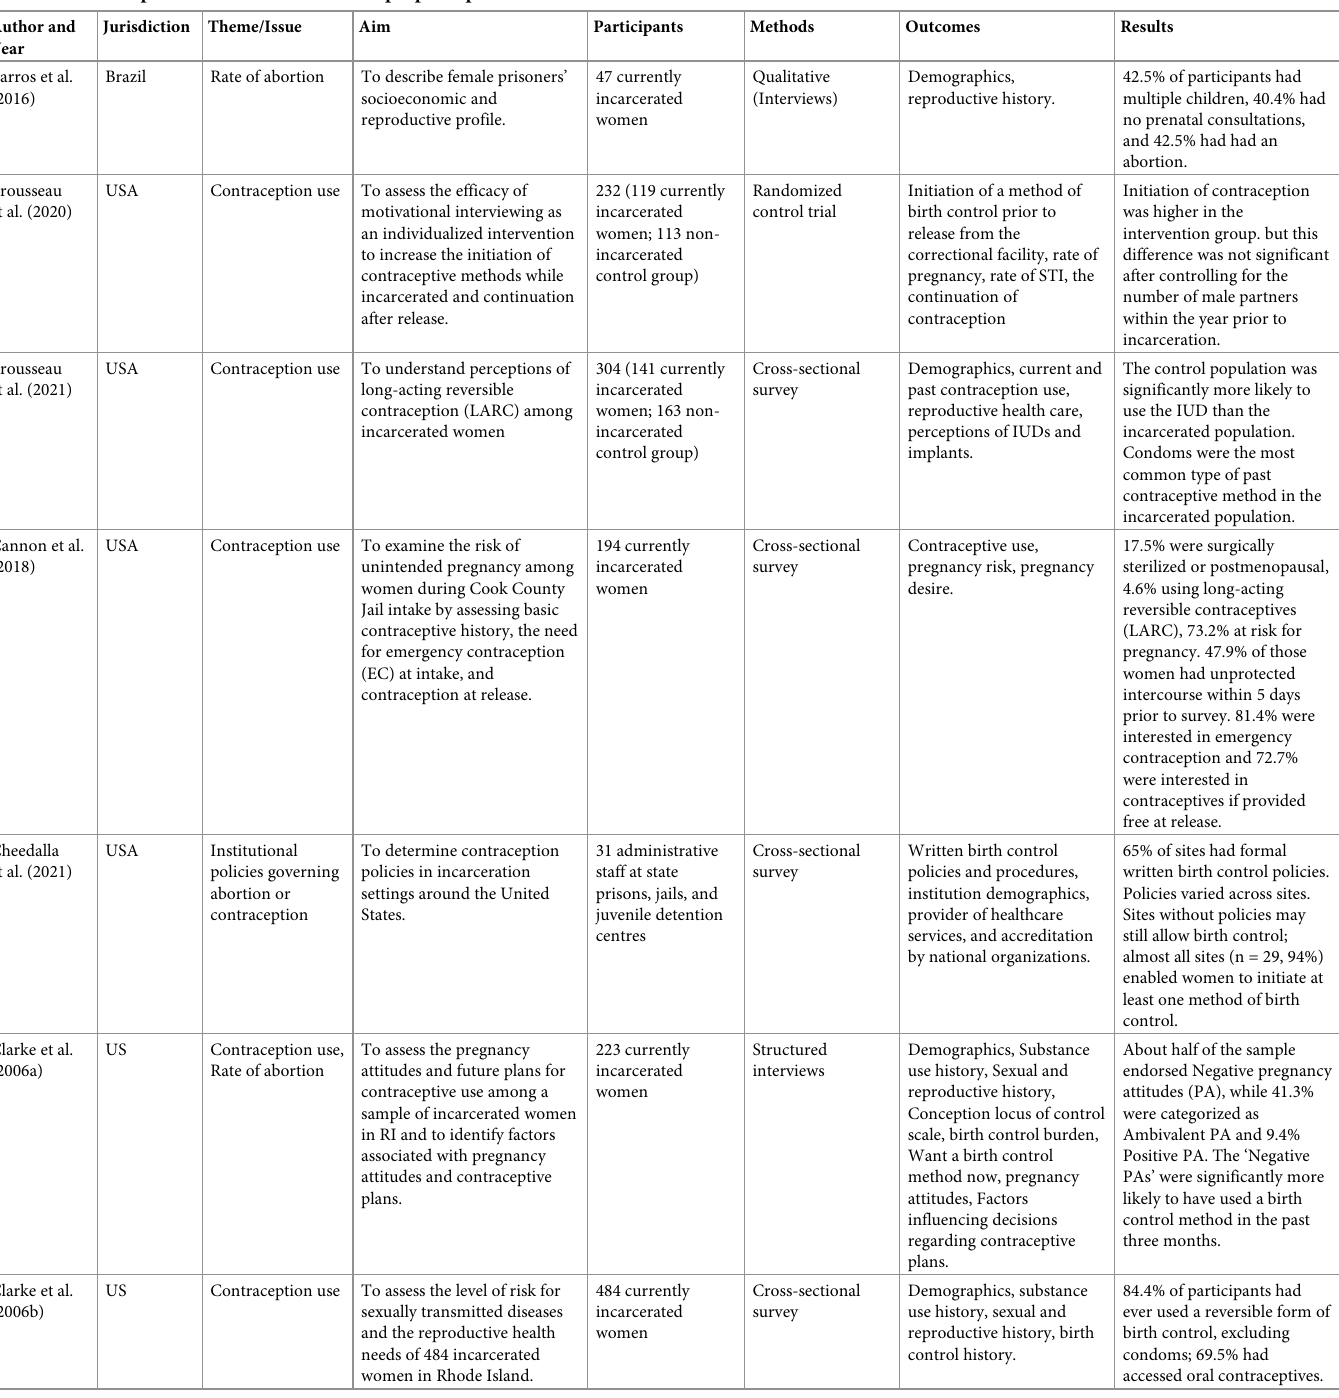
Table 1. Contraception and abortion access for people in